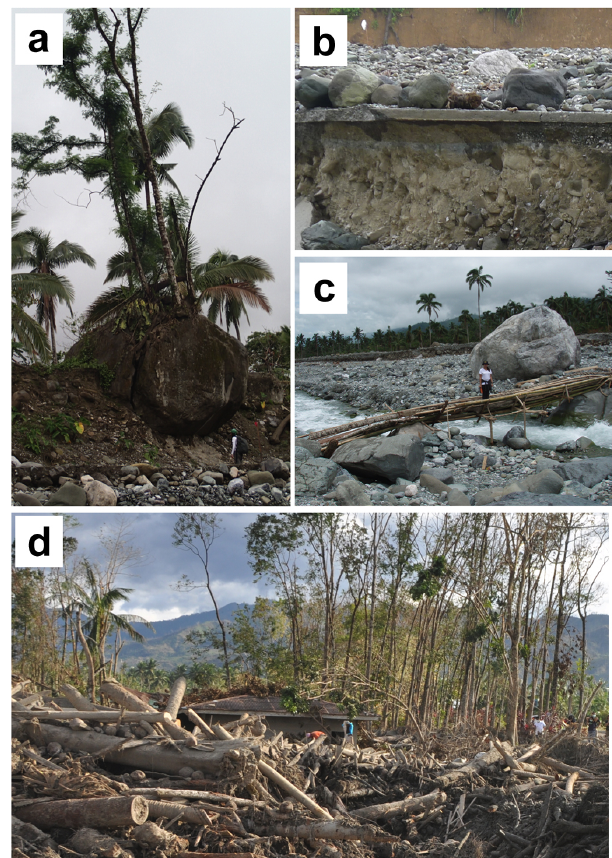
Figure 3. Debris-flow deposits in the New Bataan area. (a) Boul- der in ancient reverse-graded debris-flow deposit. Well-established trees indicate an age of some decades prior to the settlement of the town. (b) Old debris-flow deposits underlying New Bataan – An- dap highway. Boulders are separated from each other by a matrix of finer-grained sediment. For scale, the concrete is 15cm thick. The coarse sediment atop the highway are new debris-flow